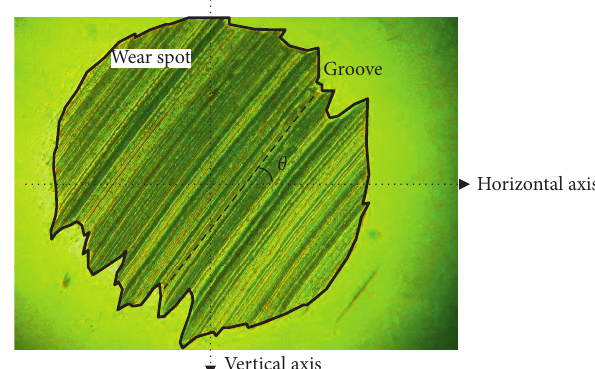
Figure 1: Groove and its